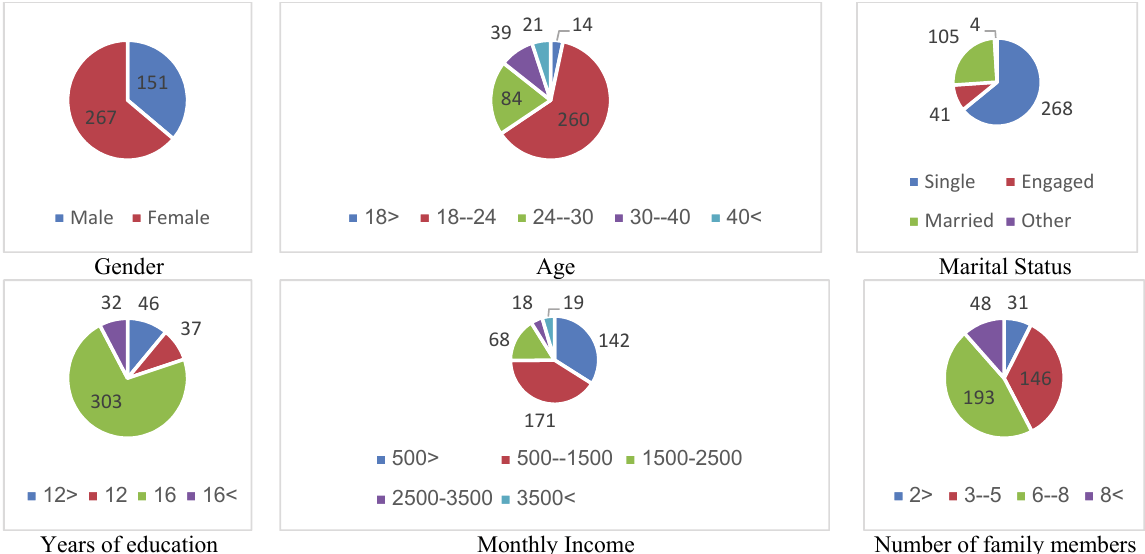
Fig. 1. Personal characteristics of the